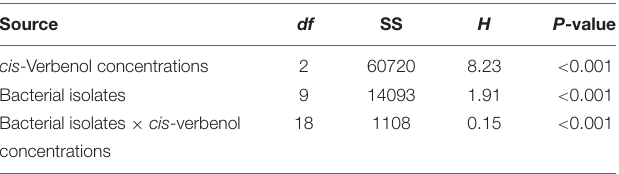
TABLE 2 | Statistics for association between facultative bacteria and pheromone cis- verbenol concentration using Scheirer–Ray–Hare test. Source df SS H P -value cis -Verbenol concentrations 2 60720 8.23 < 0.001 Bacterial isolates 9 14093 1.91 < 0.001 Bacterial isolates × cis -verbenol 18 1108 0.15 < 0.001 concentrations